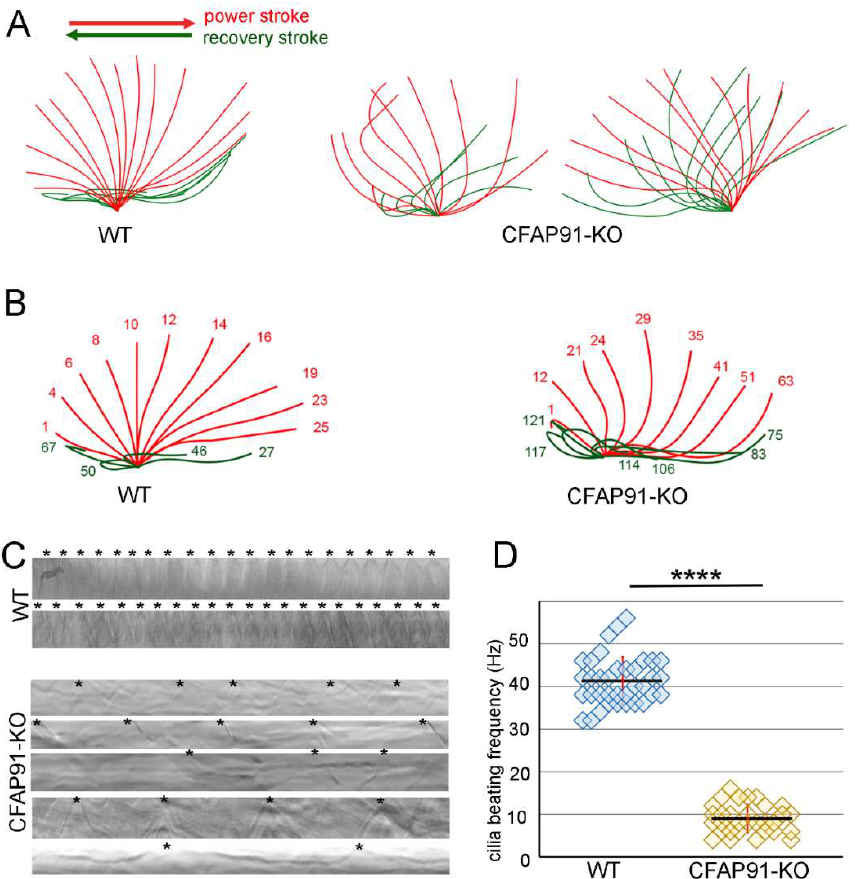
Figure 4. Lack of Cfap91 drastically reduces cilia beat frequency. ( A ) Drawings representing subse- quent positions of the cilium during the power (red) and recovery stroke (green) of wild-type and CFAP91-KO mutant cells swimming in SPP medium, prepared based on recorded movies. ( B ) Drawings as in (A) but with indicated numbers of movie frames when the particular cilium position was reached. Cells were recorded in a mix of SPP medium and 1.5% methylcellulose. ( C ) Examples of kymographs of cilia motility recorded for 0.5 s (450 frames), analyzed using the ImageJ program, and used to calculate the cilia beating frequency. Ciliary beat cycles marked by stars *. ( D ) Graph showing measurements of cilia beating frequency in wild-type (WT) and CFAP91-KO mutant. Number of analyzed kymographs: WT (5 cells, 36 kymographs), CFAP91-KO (8 cells, 34 kymo- graphs). Calculated p -value ( t -test): WT/91-KO 5.29 × 10 −36 (indicated by four stars ****).